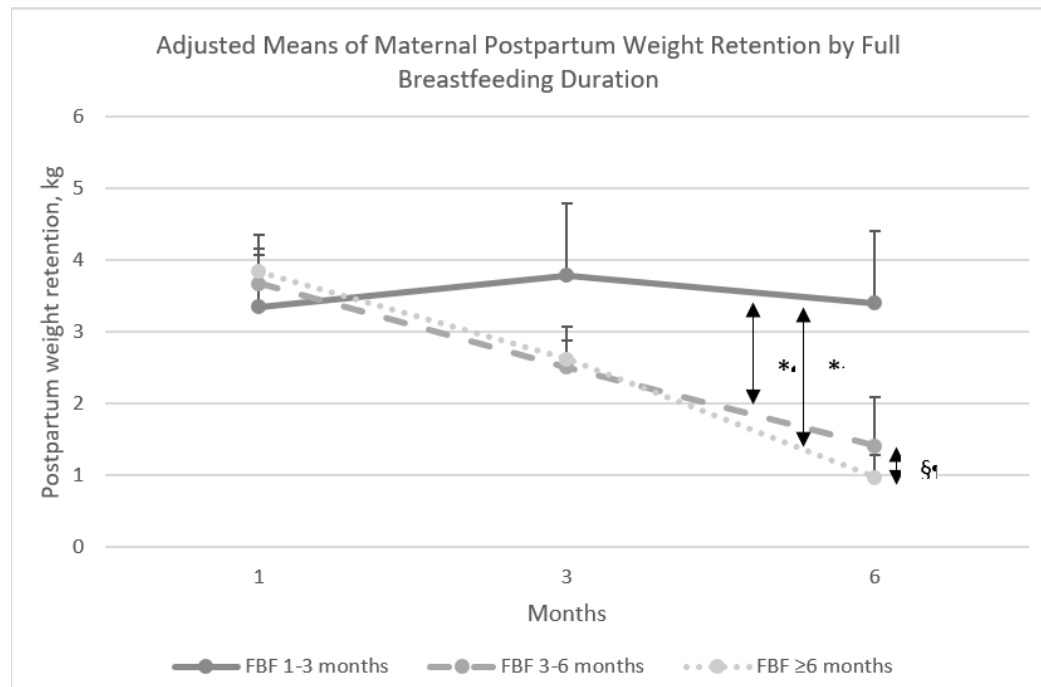
Figure 1. Adjusted means of maternal postpartum weight retention by full breastfeeding duration.